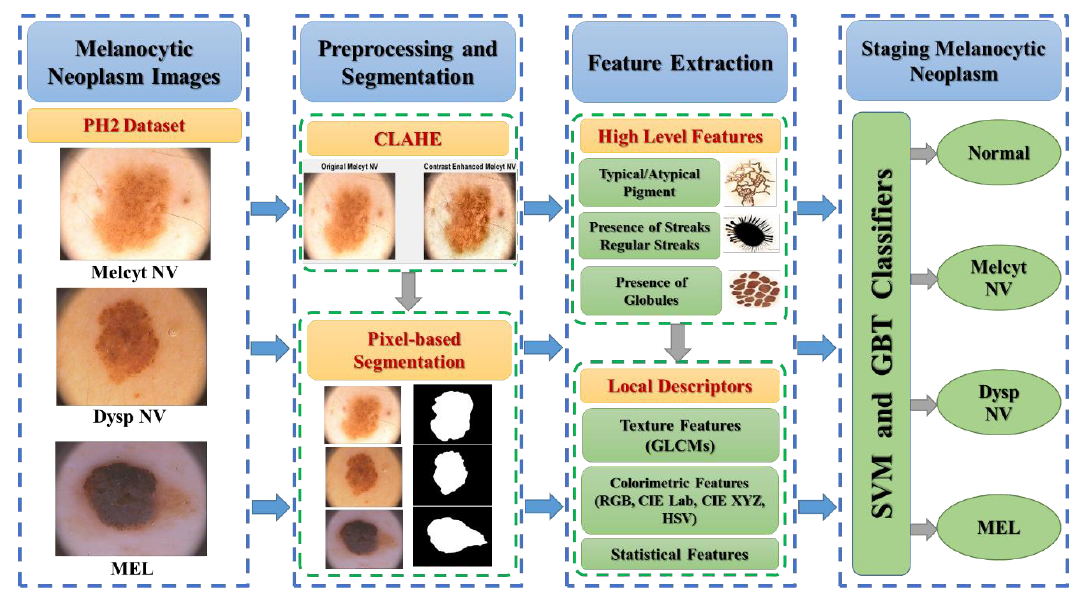
Figure 6. The non-invasive melanocytic neoplasm staging framework.